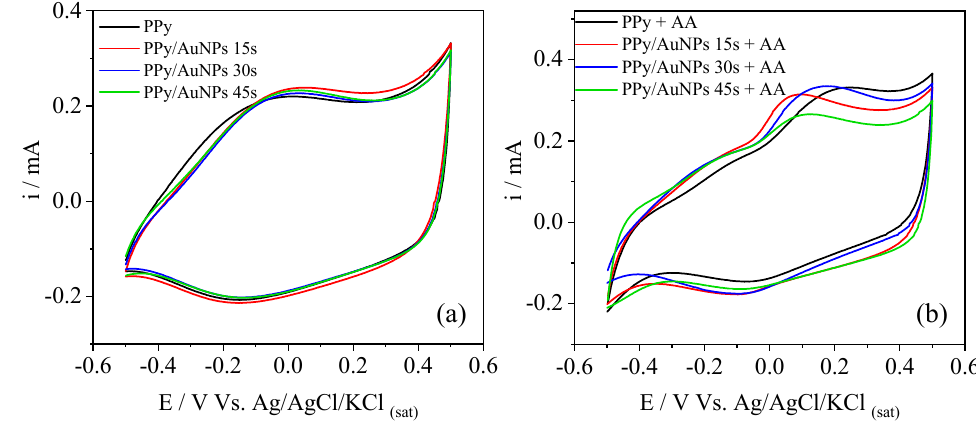
Figure 4. Cyclic voltammetry of PPy, PPy/AuNPs 15 s, PPy/AuNPs 30 s, and PPy/AuNPs 45 s in ( a ) PBS electrolyte and ( b ) PBS electrolyte containing 5 mmol L − 1 of AA. Scan rate = 20 mV s − 1 .